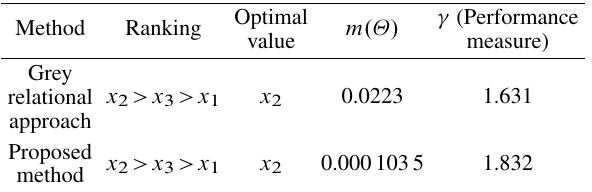
Table 4 Comparison of different methods in Example 3.